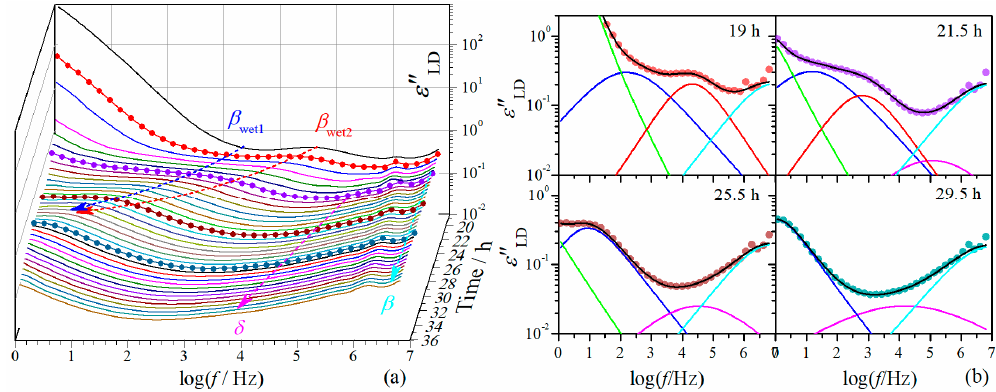
Figure 4. ( a ) Frequency dependence of derivative dielectric loss ε ” LD of regenerated cellulose film at different drying moments at the second drying stage. The symbol-line curves are randomly selected moments used as fitting examples and the arrows are for guiding the eyes. ( b ) Fits on the derivative dielectric loss spectrum at randomly selected moments as highlighted in (a). The lines are fitting curves, black: total fit, green: ionic motion relaxation, blue: β wet1 -relaxation, red: β wet2 -relaxation, magenta: δ -relaxation, cyan: β -relaxation.